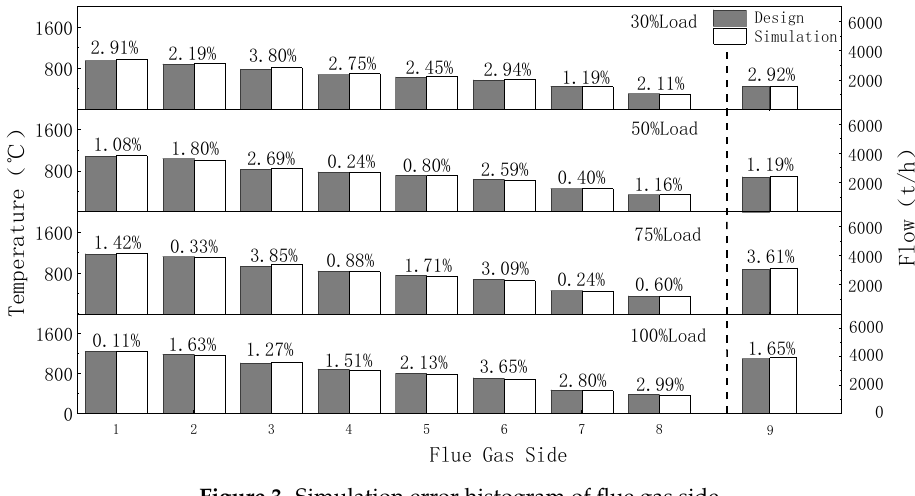
Figure 3. Simulation error histogram of flue gas side.